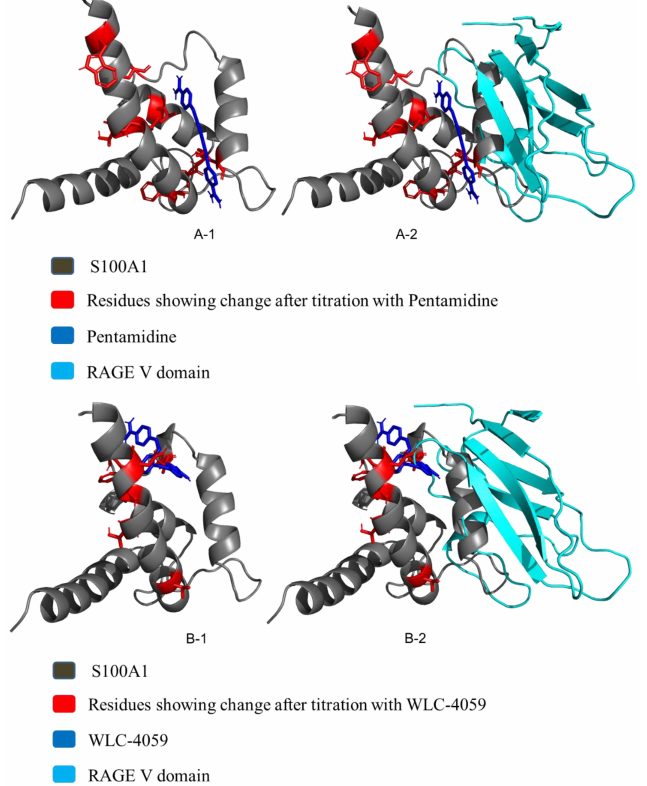
Figure 3. ( A ): S100A1 and pentamidine complex. ( A-1 ): The HADDOCK complex after the HAD- DOCK run of S100A1 and pentamidine. ( A-2 ): Overlapping of the haddock complex with the RAGE V domain. ( B ): S100A1 and the Pentamidine derivative (WLC-4059) complex. ( B-1 ): The HADDOCK complex after the HADDOCK run of S100A1 and WLC-4059. ( B-2 ): Overlapping of the haddock complex with the RAGE V